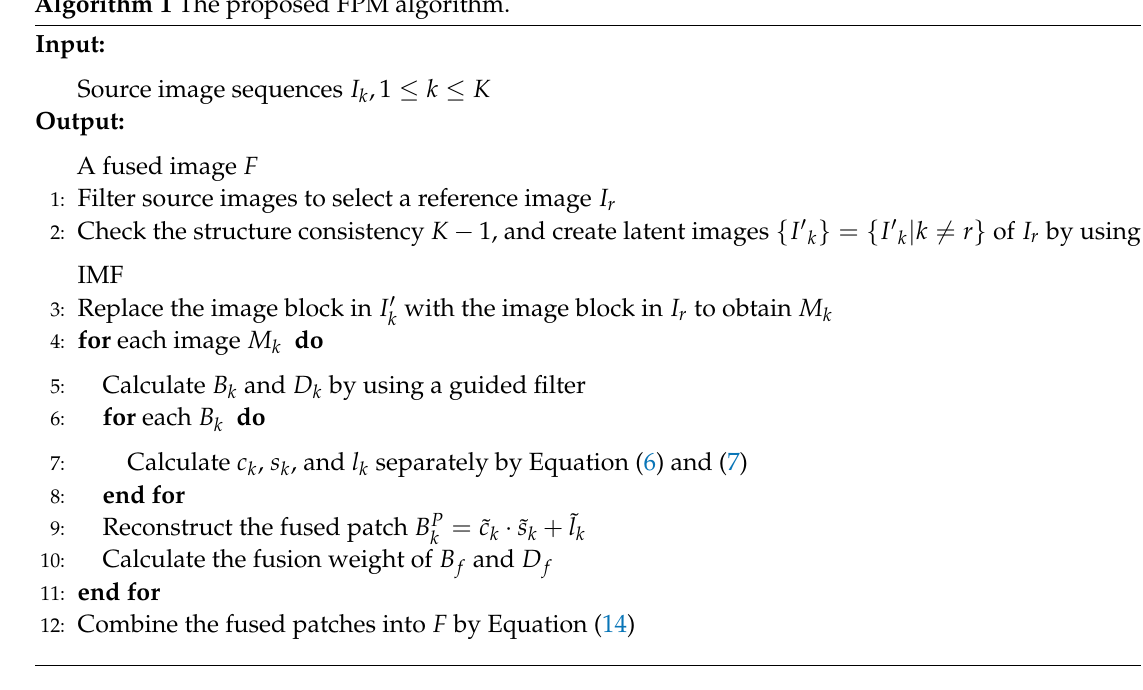
Algorithm 1 The proposed FPM